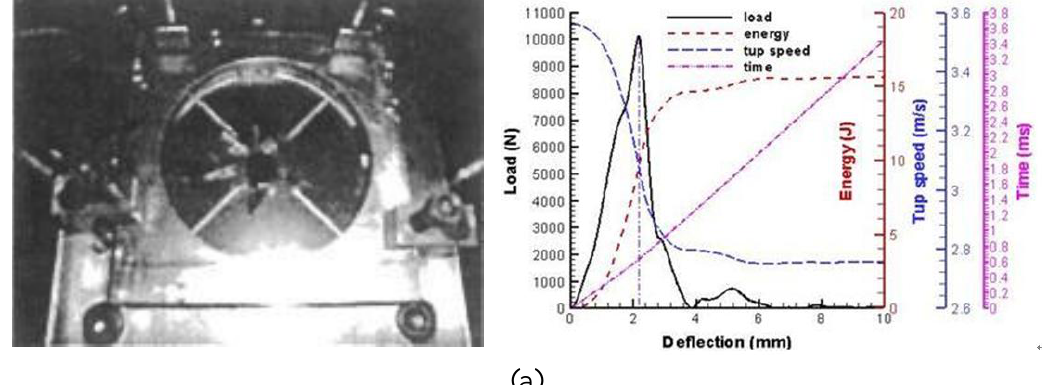
Figure 13. The study of 3D punch-shear of vinyl ester (a) experimental results; (b) HLPM results. Maximum drop velocity of indenter is 3.55